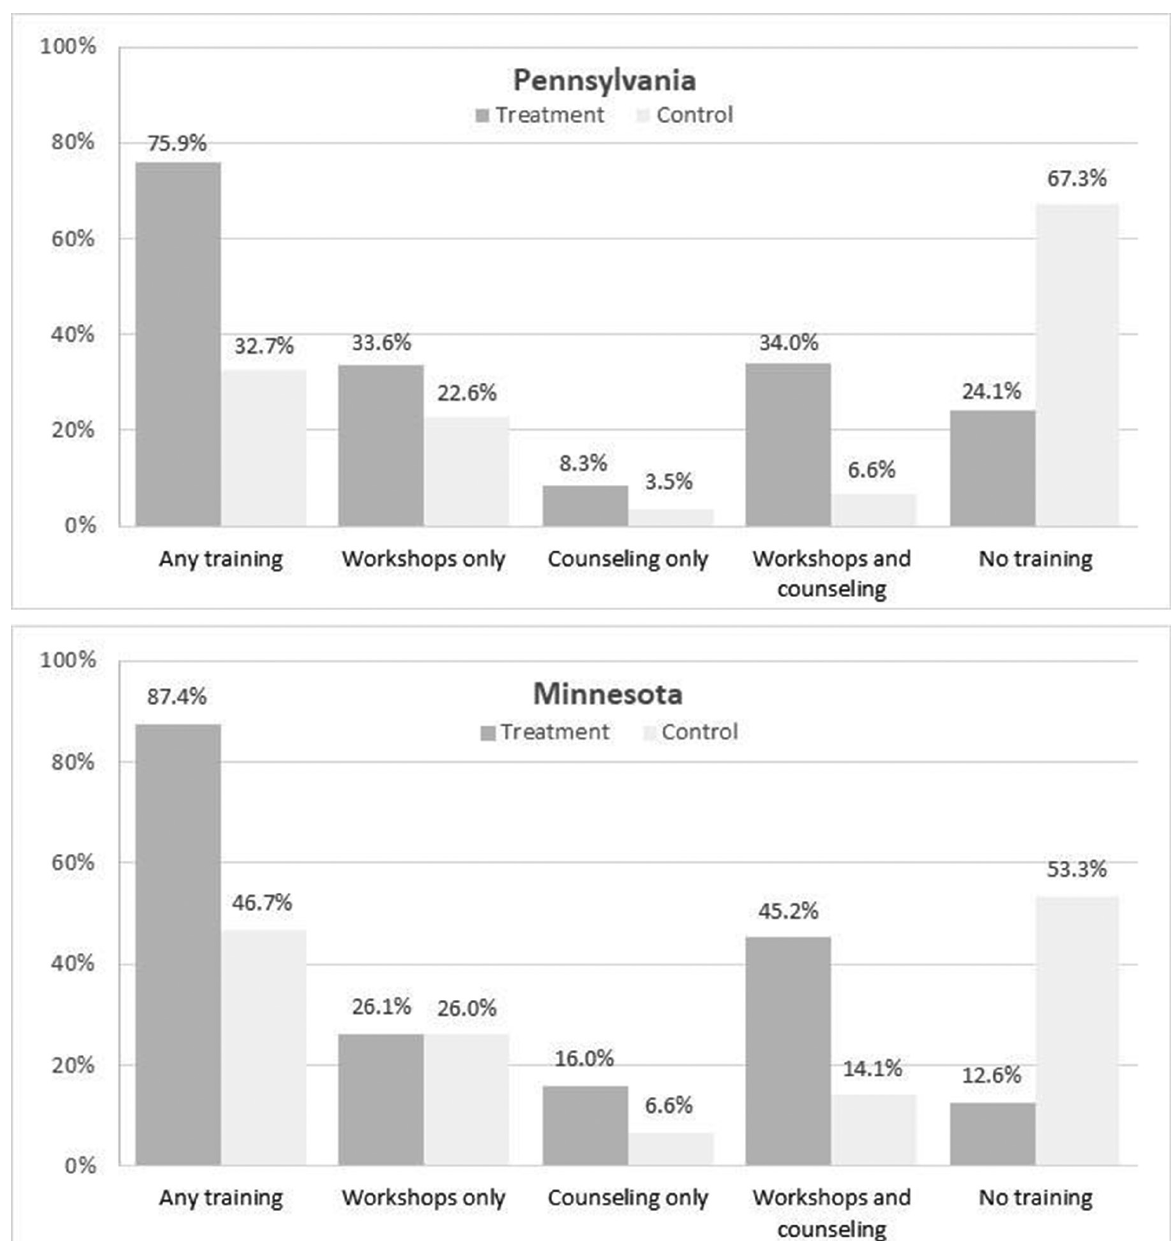
Note : Reported are sample